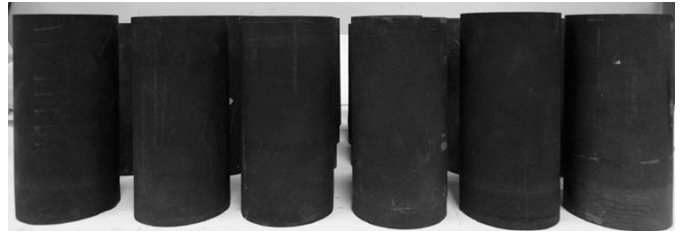
Figure 3. Shale samples used in tests.